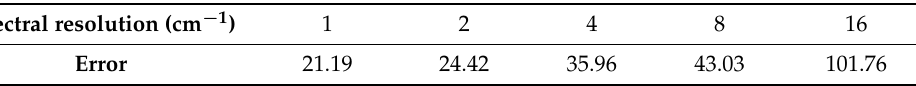
Table 2. The error of the synthetic background spectrum of C 2 H 4